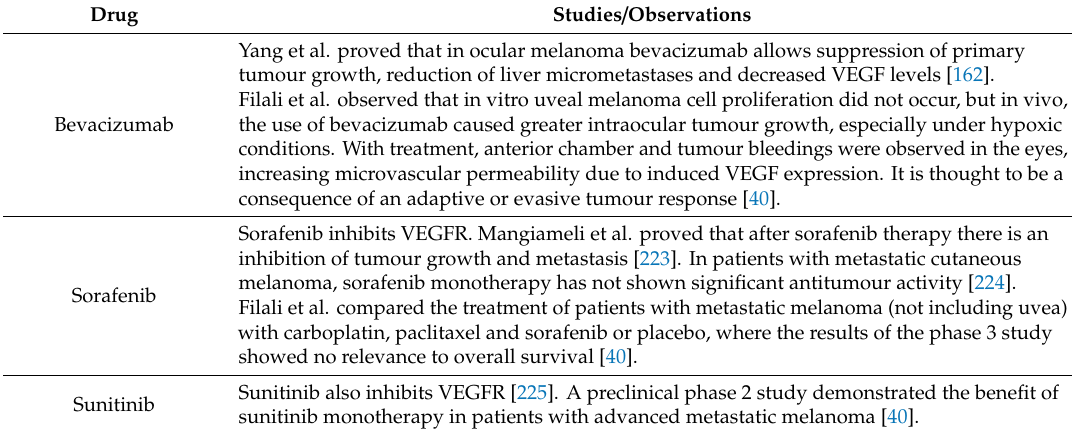
Table 1. Summary of anti-angiogenic agents and their e ff ect on tumour growth and metastases in the ocular